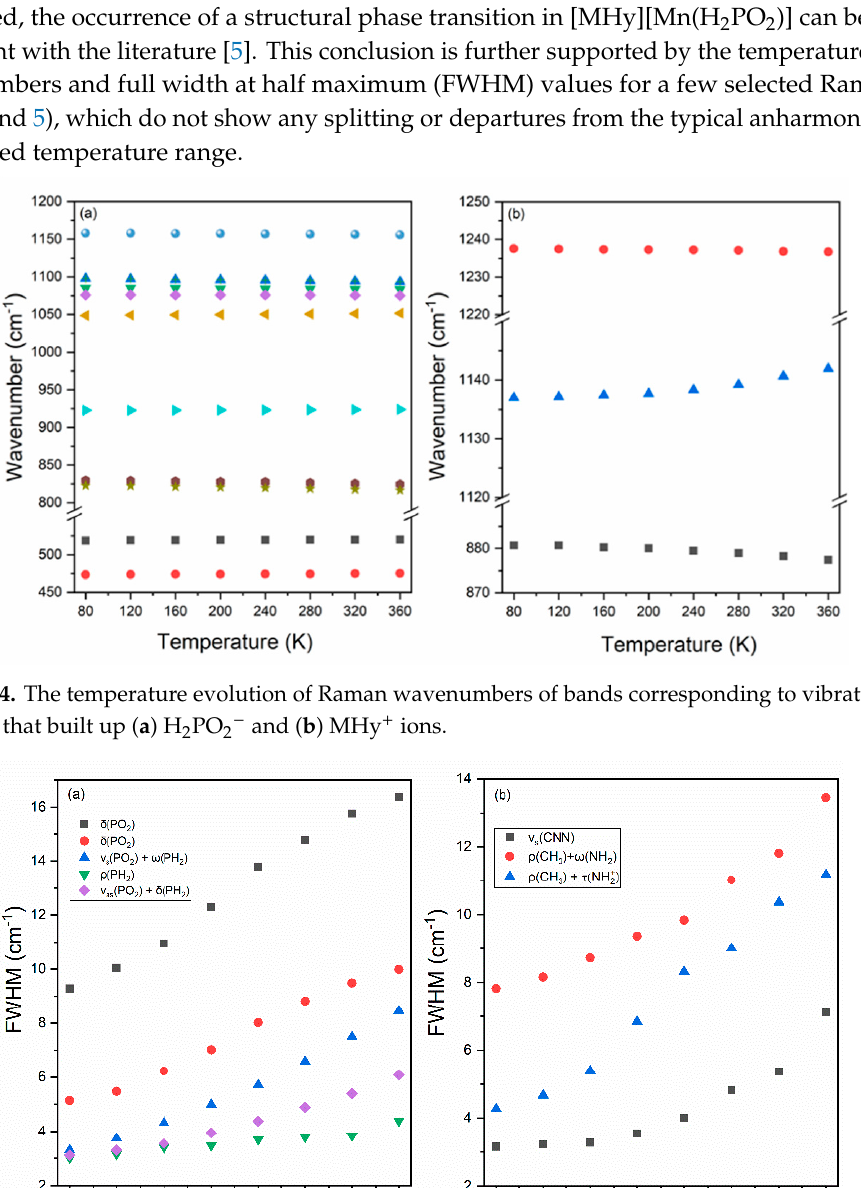
Figure 4. The temperature evolution of Raman wavenumbers of bands corresponding to vibrations of groups that built up ( a ) H 2 PO 2 − and ( b ) MHy + ions.